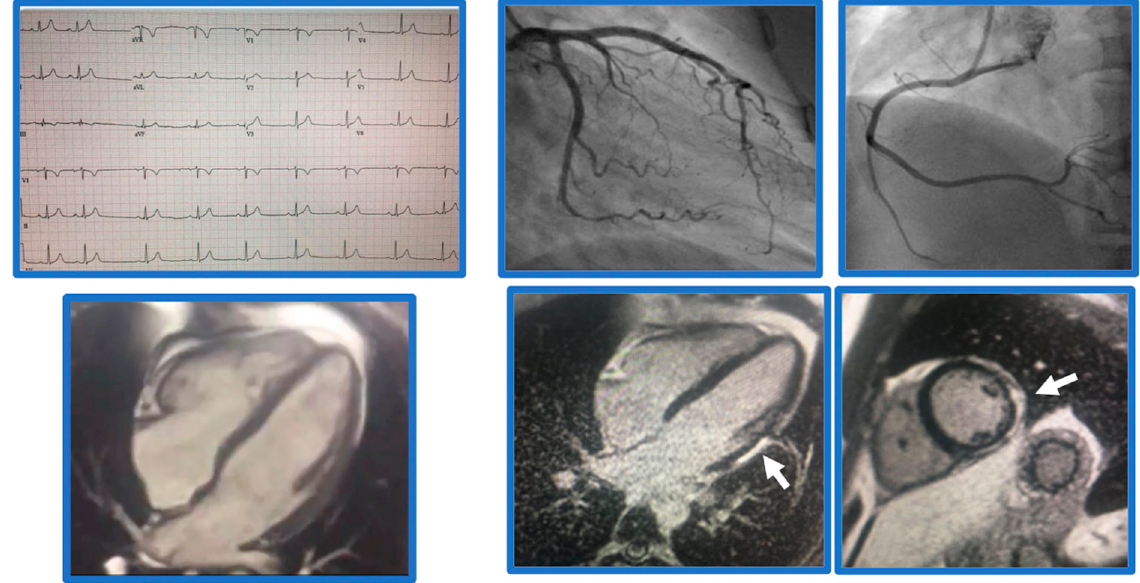
Figure 1. Demonstrative case of myocarditis. Case of a 21-year-old male patient presenting with chest pain. Found to have normal coronaries, SSFP cine imaging showed borderline LV function, EF 54%, and subepicardial basal-mid inferolateral late gadolinium enhancement (arrows), suggestive of myocarditis.